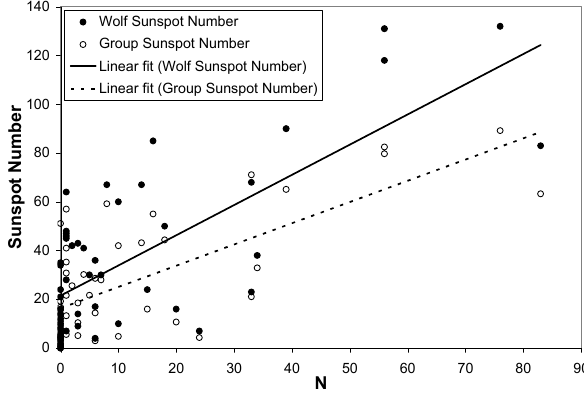
Figure 2. Relationships between the sunspot number and N . Fig. 2. Relationships between the sunspot number and N